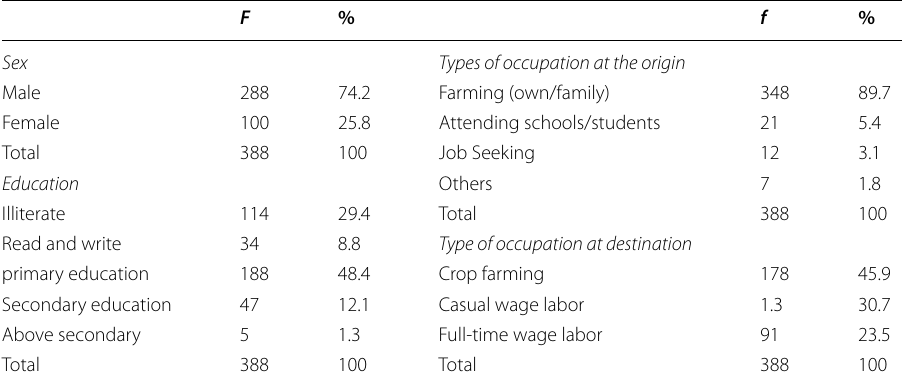
Table 1 Demographic and socio-economic characteristics of migrants. Source : Own Household Survey